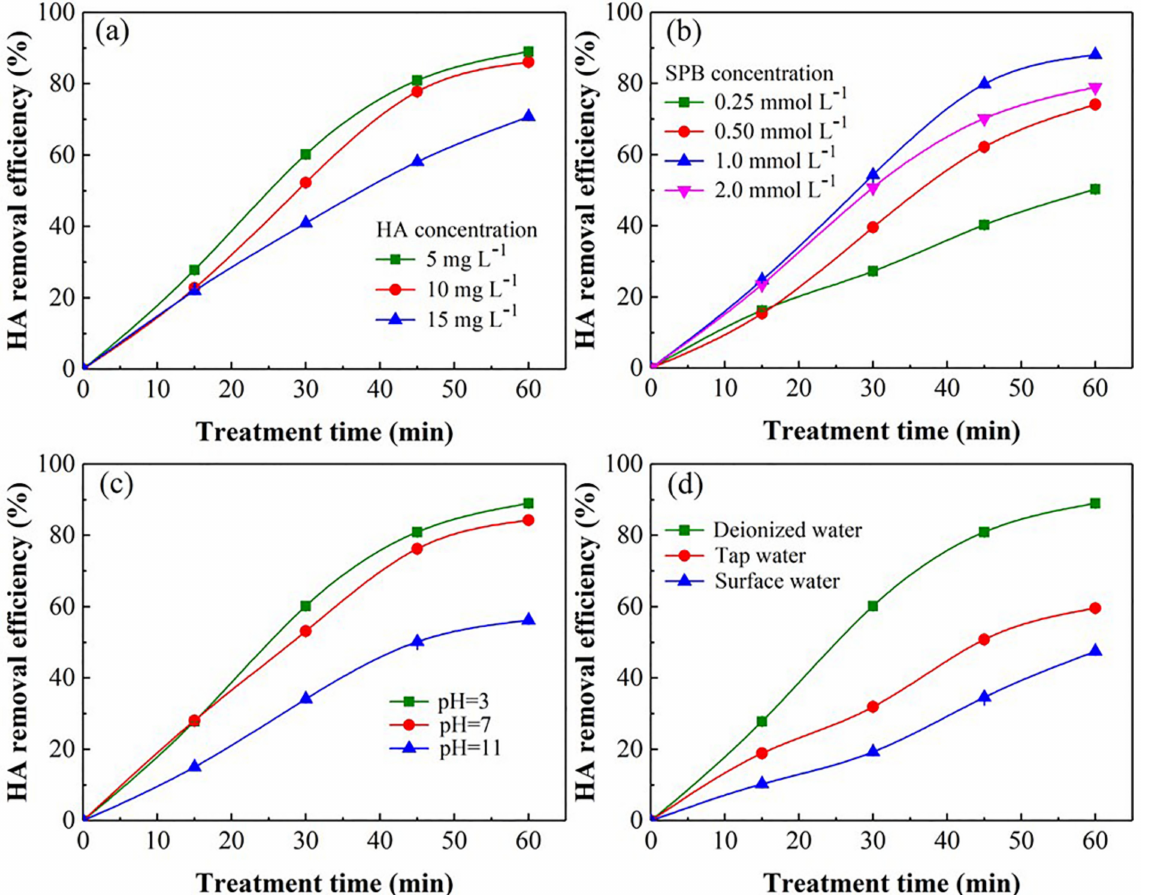
Figure 2. Influence of various parameters on HA decontamination during UV/SPB system: ( a ) HA concentration, ( b ) SPB concentration, ( c ) initial pH. ([HA] 0 = 5–15 mg L − 1 , [SPB] 0 = 0.25–2 mmol L − 1 , pH =